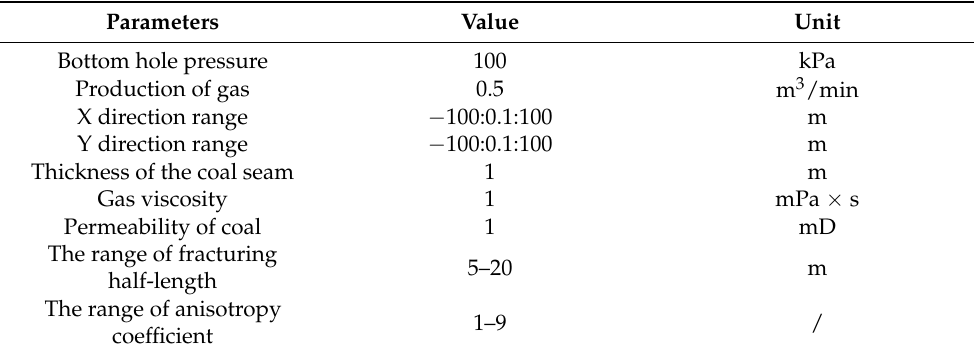
Table 2. The parameters used for the case with fractures. Parameters